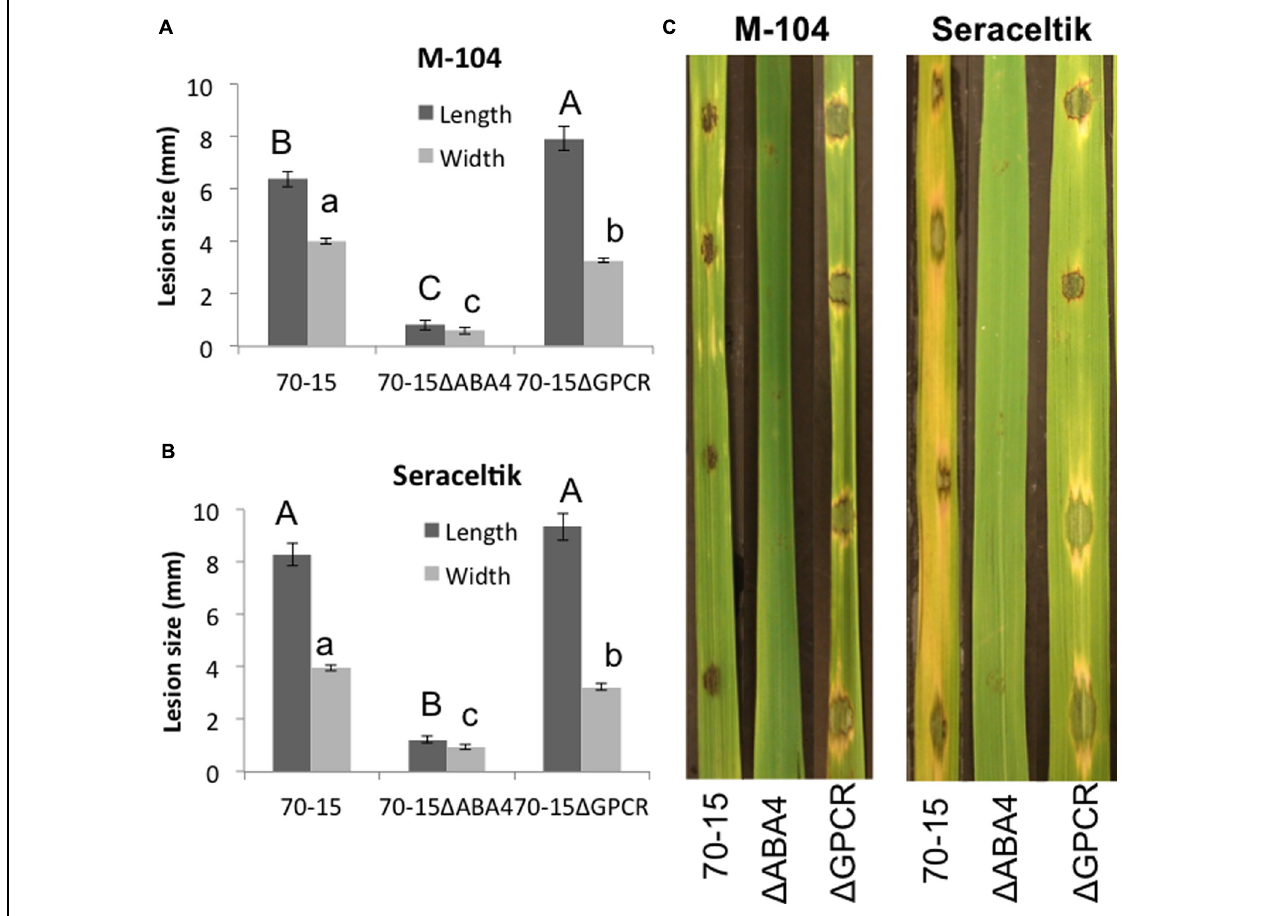
FIGURE 7 | Ability of ABA mutants to infect rice. M-104 and Seraceltik rice plants were infected with 70-15, 70-15 (cid:2) ABA4, or 70-15 (cid:2) GPCR and lesion length and width were measured. Photographs were taken 5 days after infection. Different letters represent statistical significance based on the Tukey-Kramer test ( p <